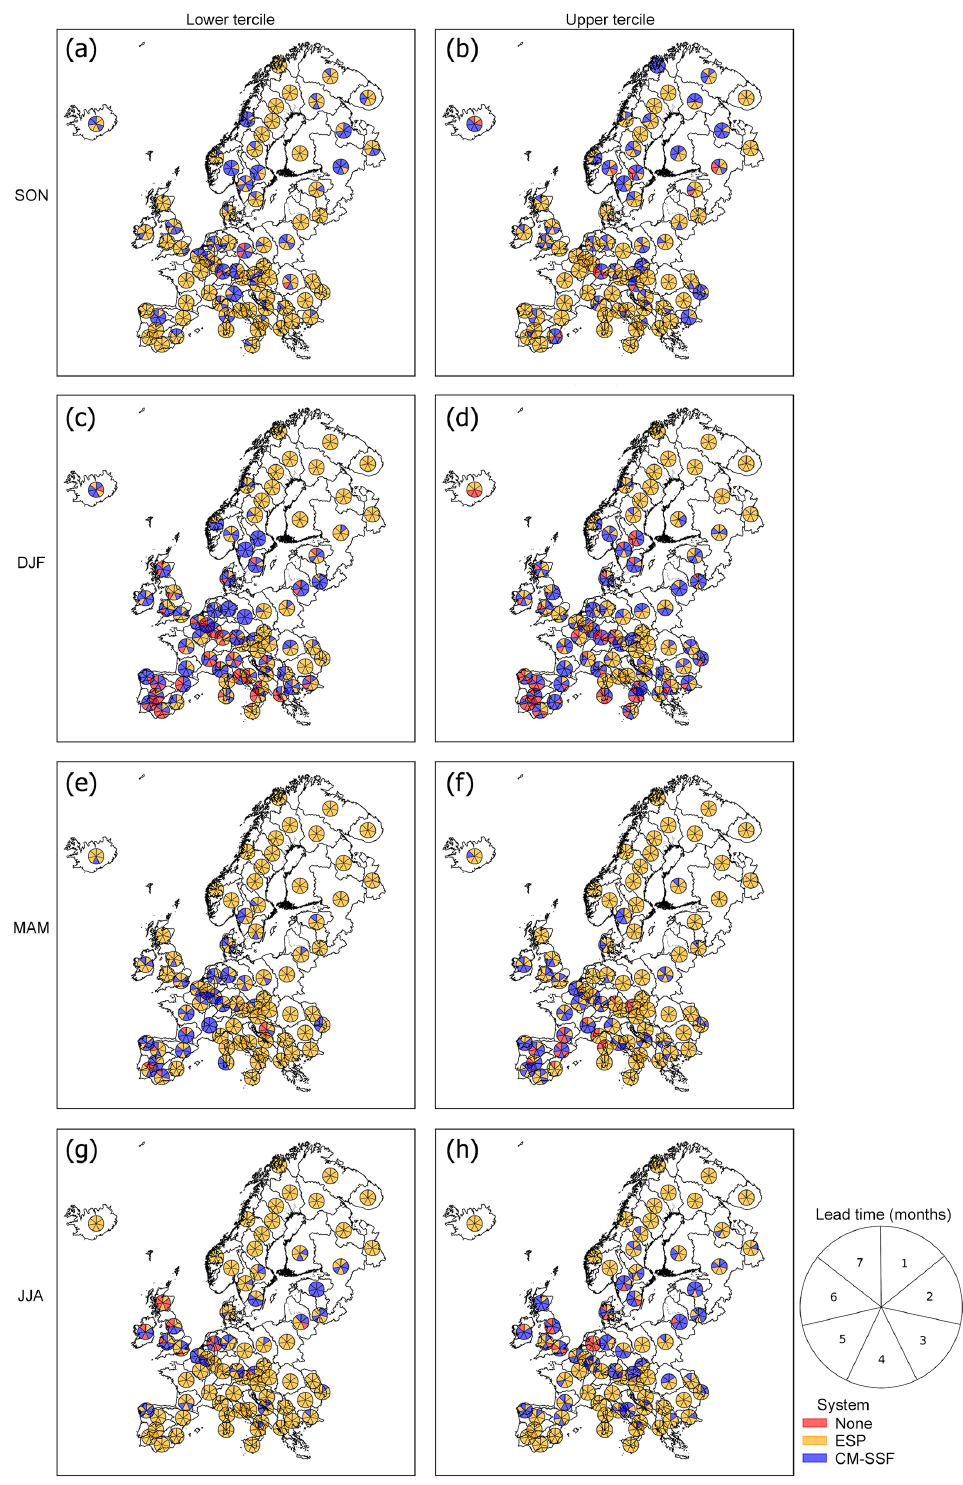
Figure 5. Maps of the best system (as measured with the ROC score) for all four seasons (SON, DJF, MAM and JJA) and the lower and upper simulated streamflow seasonal terciles (left-most and right-most columns, respectively) in each region from ( a ) to ( h ). The pie charts display the best system for each lead time (i.e. 1 to 7 months), as shown in the example pie chart on the bottom right of this figure. There are three possible cases: (1) neither the ESP nor the CM-SSF is skilful (red colours), (2) the ESP is skilful and better than the CM-SSF (yellow colours), and (3) the CM-SSF is skilful and better than the ESP (blue